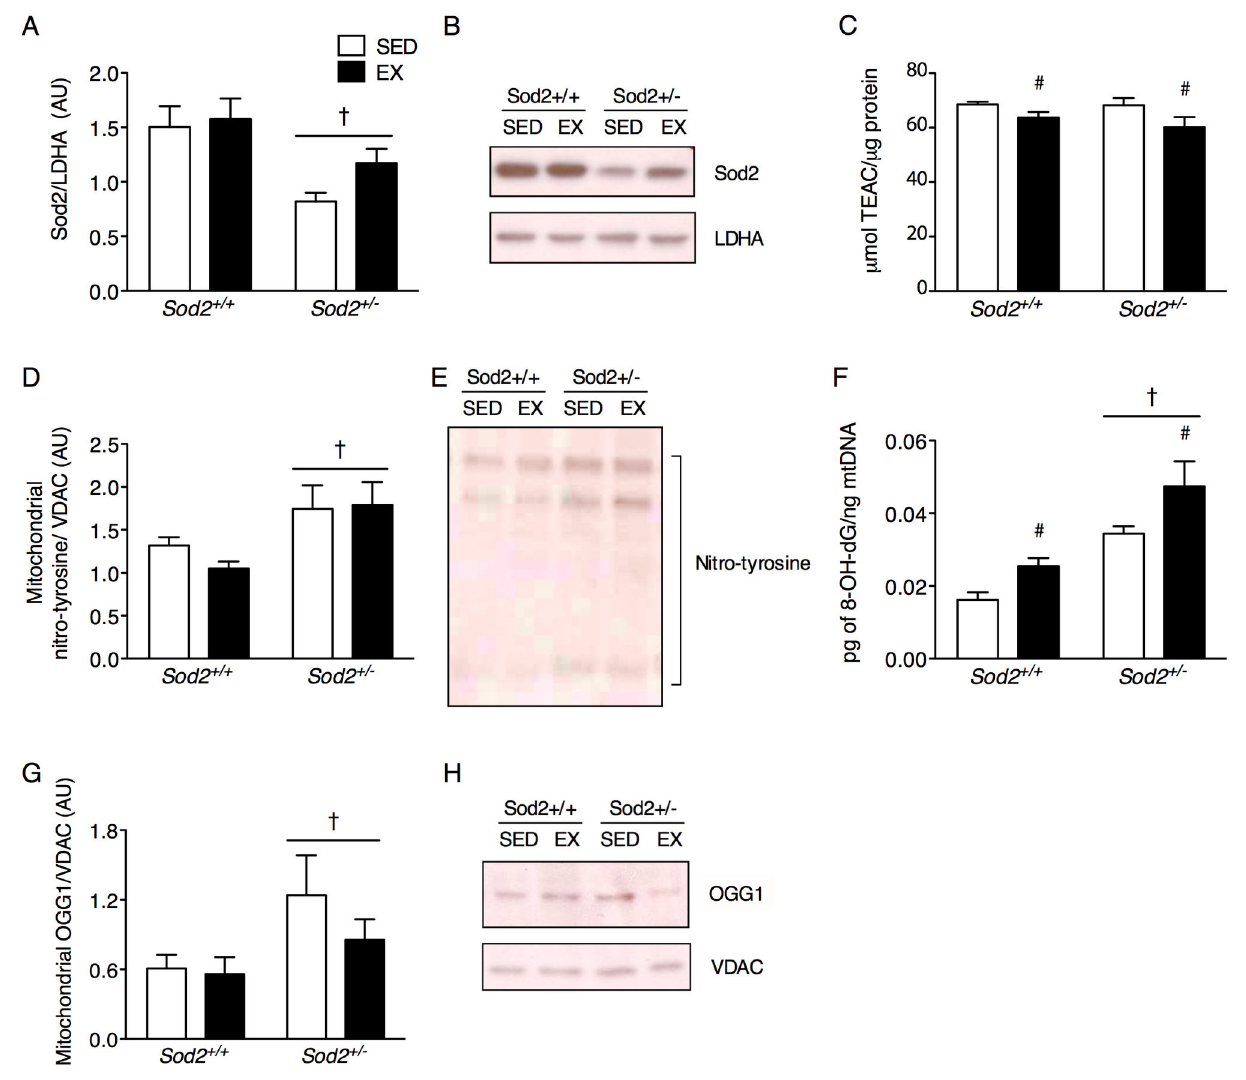
Figure 3. Mitochondrial oxidative stress persists with exercise training in Sod2 +/- mice. Total protein lysates were prepared from tibialis anterior muscle and isolated mitochondrial lysates from quadriceps femoris muscle (A) Sod2 protein in total lysates relative to LDHA and (B) representative immunoblots. (C) Non-enzymatic anti-oxidant capacity of mitochondrial lysates per amount of protein measured expressed as Trolox Equivalent Antioxidant Capacity (μmol TEAC/μg protein). (D) Quantification of mitochondrial nitro-tyrosine and (E) representative immunoblots. For the results of the non-significant oxidative damage modifications 4HNE and protein carbonyls, see Figure S2A-B. (F) Levels of the oxidative lesion 8-hydroxy-2-deoxyguanosine in isolated mitochondrial DNA digested to single bases. (G) Expression of the DNA repair enzyme OGG1 in isolated mitochondrial lysates relative to VDAC and (H) representative immunoblots. n = 8-10 per group for all measurements. All data are mean±SE. # Indicates a main effect of exercise training ( p < 0.05). † Indicates a main effect of genotype ( p < 0.05). doi: